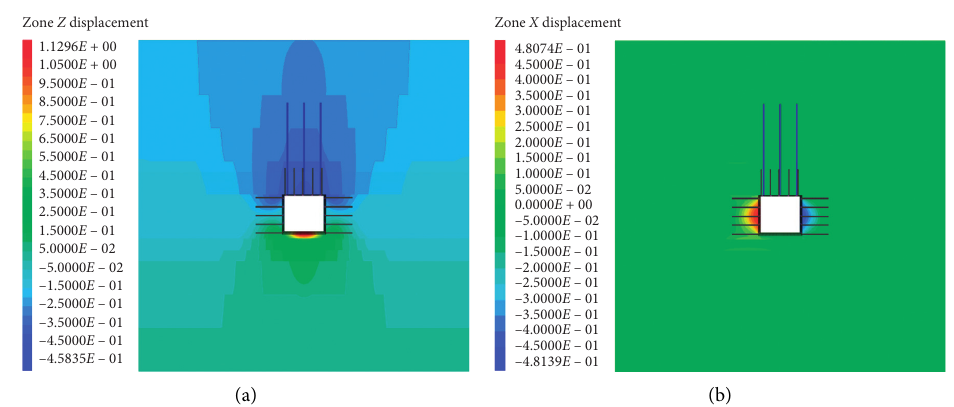
Figure 24: Numerical simulation of displacement nephogram of #15 haulage